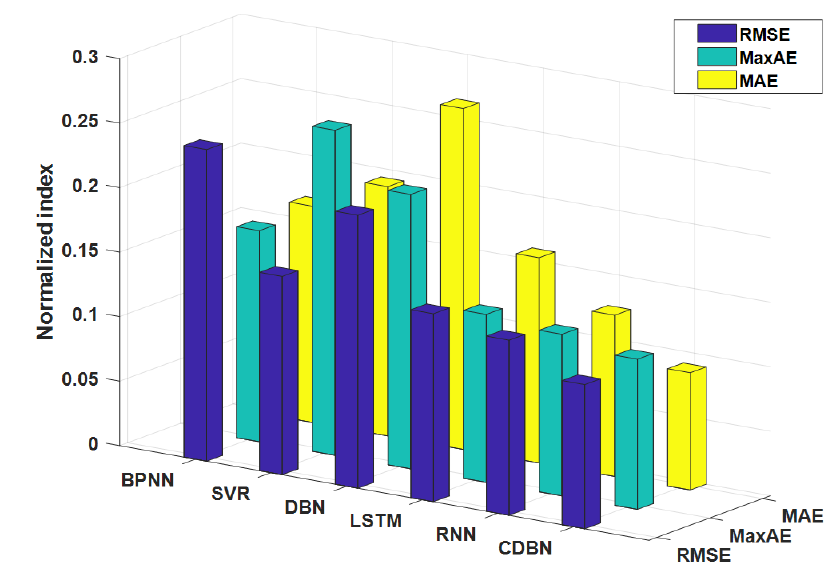
Figure 12. Performance evaluation chart of different fault prognosis